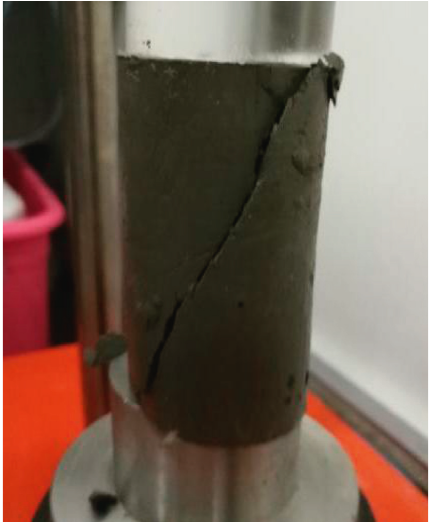
Figure 4: Failure mode of cement-admixed slurry specimen with a cement content of